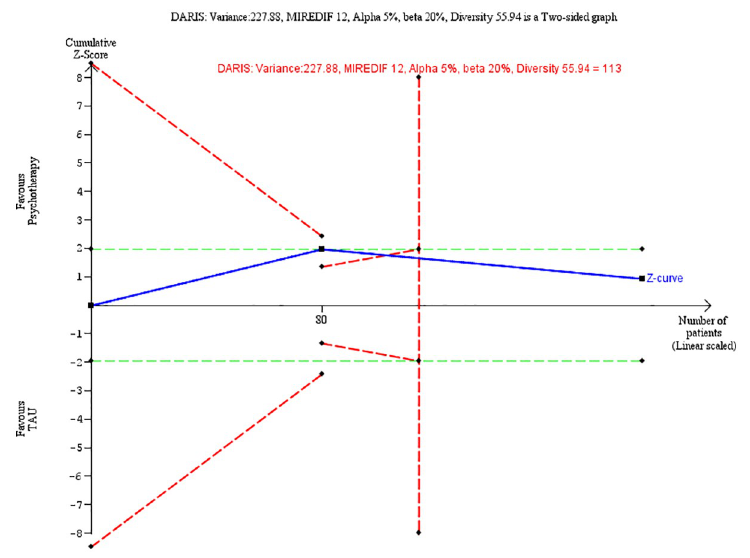
Fig 5. Trial Sequential Analysis for